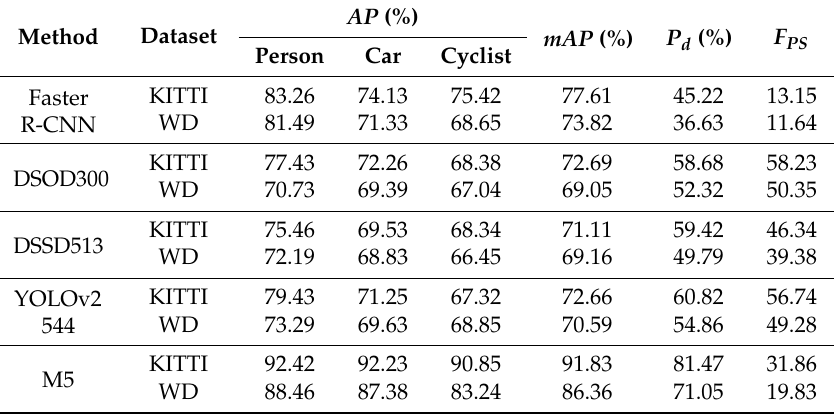
Table 4. Comparison of detection and recognition effects of other algorithms.